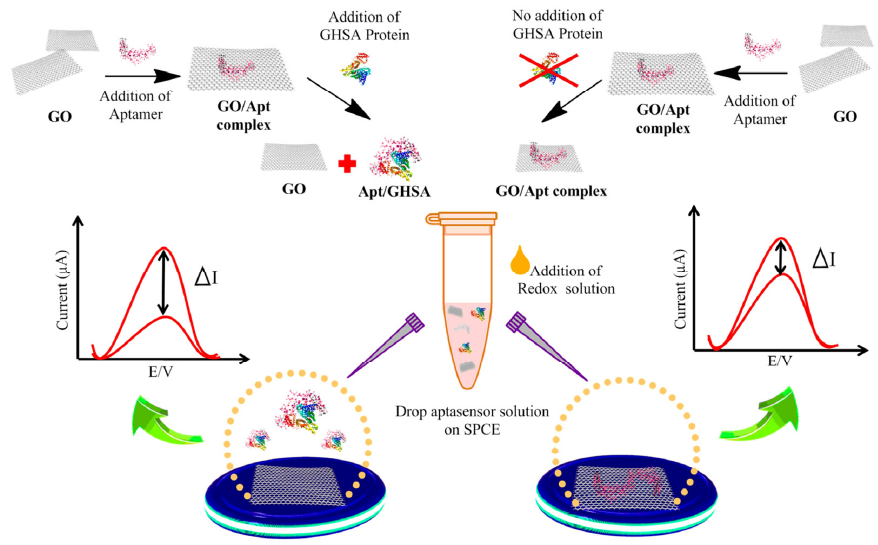
Figure 8. Aptasensor for glycated human serum albumin (GHSA) detection, using graphene oxide (GO) as the substrate for aptamer adsorption. Adapted with permission from Waiwinya et al. [82] (under the terms and conditions of the Creative Commons CC BY License 4.0).